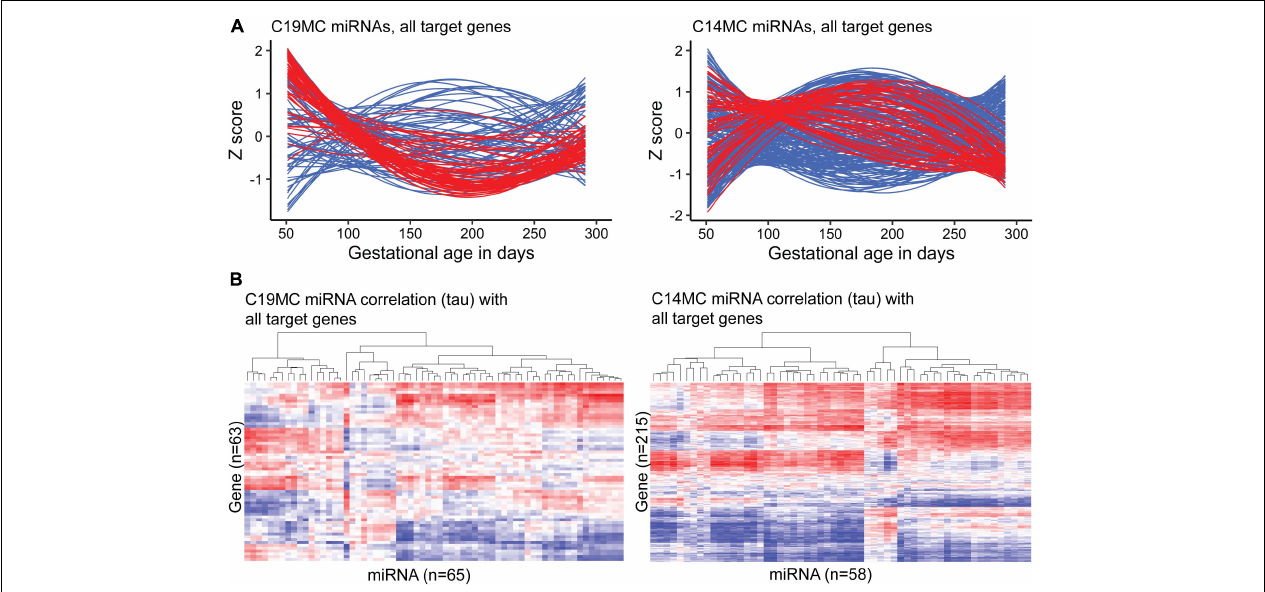
FIGURE 3 | Expression dynamics of C19MC and C14MC miRNA clusters across gestation compared to the transcript levels of their miRTarBase target genes. Placental transcript levels were confidently quantified for 63/76 and 215/262 predicted target genes of C19MC and C14MC, respectively. (A) miRNA and gene expression levels during pregnancy presented in Z -scores; expression data for miRNAs is shown in red and for target genes in blue. (B) Heatmap and hierarchical clustering of miRNA–target gene expression data based on the calculated correlation coefficient Kendall tau.